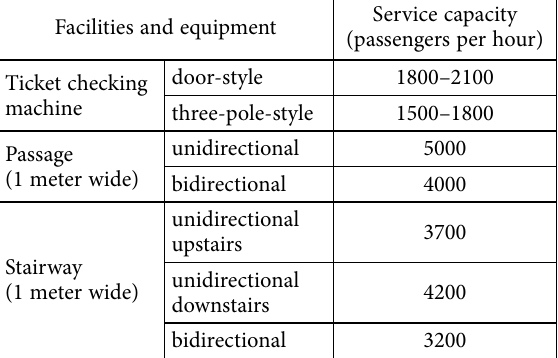
Table 3. Service capacities of some facilities and equipment Facilities and